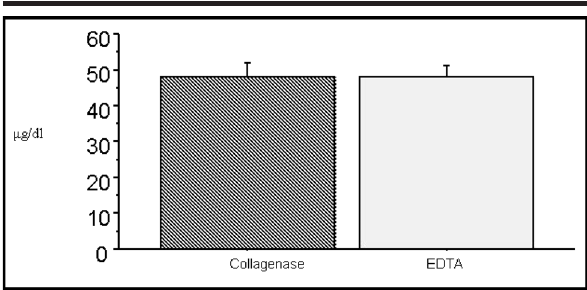
FIGURE 1 - Viability of isolated cultured hepatocytes obtained by EDTA and collagenase